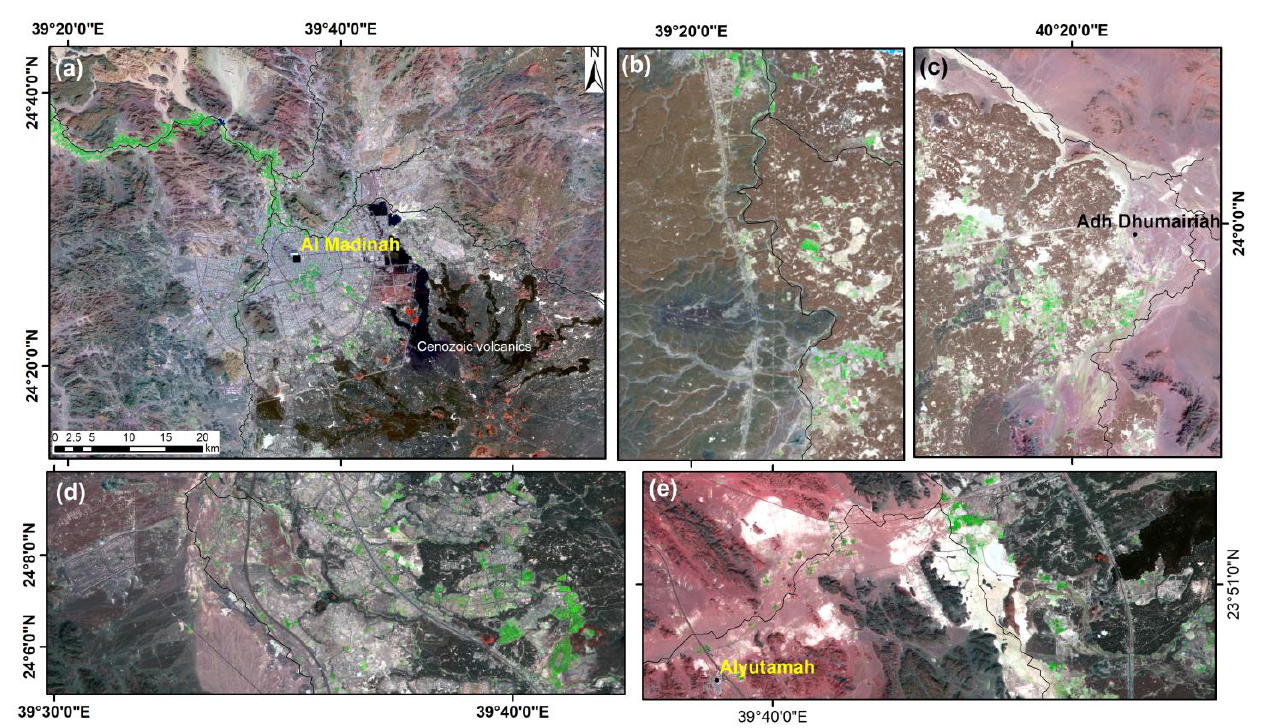
Figure 11. Landsat-9 of the study area ( a ) vegetated areas around Al Madinah and Quaternary volcanics in black; ( b ) Al Yutamah farms south of Al Madinah; ( c ) Adh Dhumainah farms south of Al Madinah; ( d ) band combination 12, 8, 3 of Sentinel-2 of the area south of Al Madinah; ( e ) Sentinel-2 of Alyutamah area reveal the signature of surface water in a bright tone. Polygon in magenta color in Figure 8 is the reference location for these sub-figures.